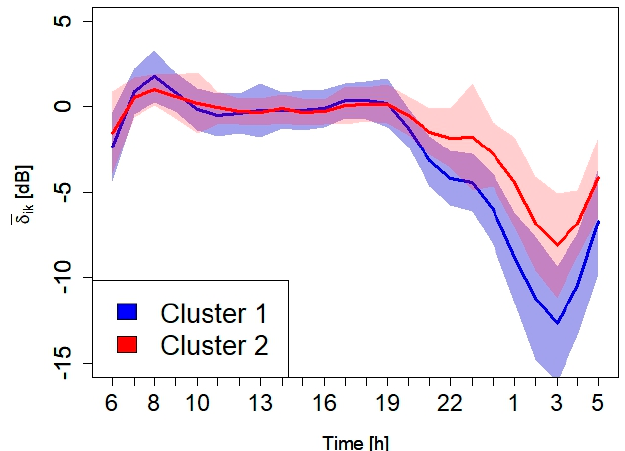
Figure 2. Mean cluster normalized equivalent level profiles (continuous lines), δ ik (dB), for the two clusters, k = (1,2), as a function of hour i of the day (also indicated with the letter h ). We show the corresponding dispersion of the hourly values within √2 standard deviation, σ (colored bands). We will use also the notation δ C1 ( h ) and δ C2 ( h ) for the mean equivalent noise levels of Clusters 1 and 2 as a function of hour h . Cluster 1 has 56 elements and Cluster 2 has 37 components. Details on the measurements and analysis related to this figure are reported in [29,33,39].